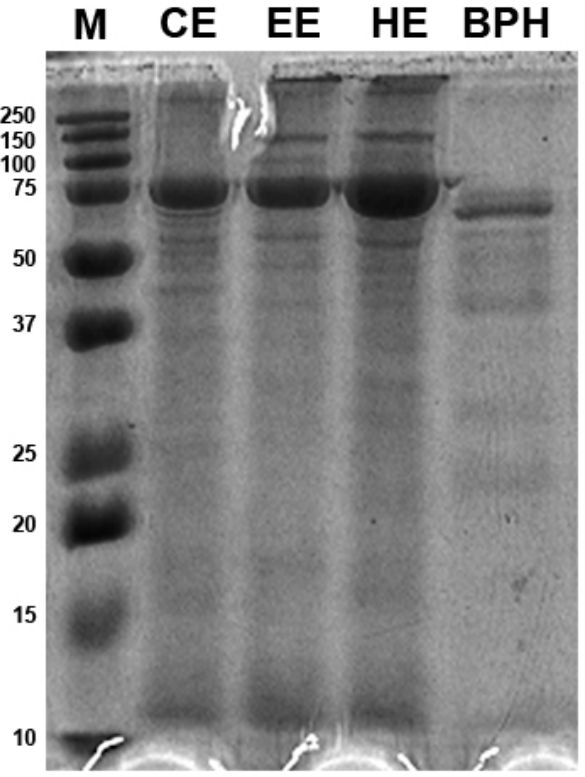
Figure 1. Protein patterns of black soldier fly (BSF) protein extracts and BSF protein hydrolysates (BPHs) resolved by Sodium Dodecyl Sulphate Polyacrylamide Gel Electrophoresis (SDS-PAGE). M, marker; CE, chloroform extract; EE, ethyl acetate extract; HE, hexane extract; BPHs, BSFL protein hydrolysates.